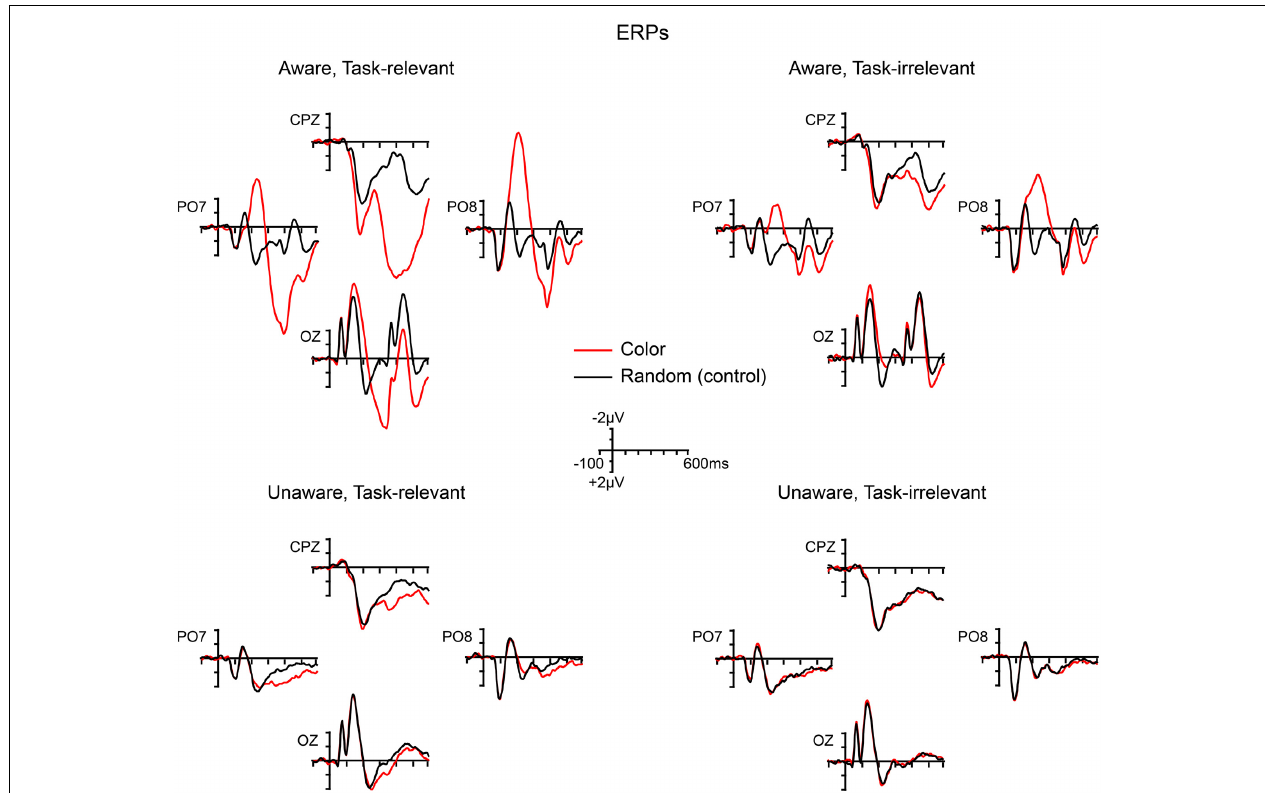
FIGURE 6 | Grand-averaged ERPs elicited by color (4-red-lines) and random (control) stimuli across the four main experimental